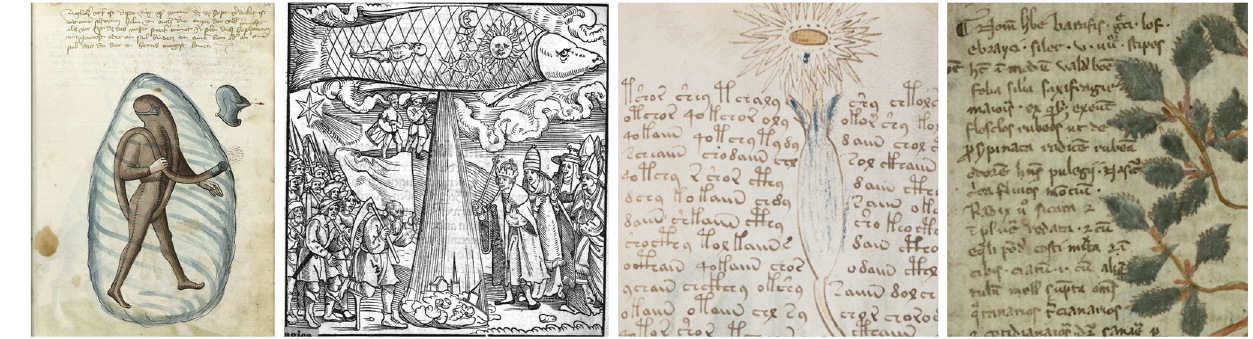
Fig 1. Four examples of historical codices. From left to right: MS Thott . 290 . 2° (1459; Photo: Royal Danish Library); Practica uber die grossen und manigfeltigen Coniunction der Planeten (1523; Photo: SLUB Dresden); Voynich Manuscript (Photo: Beinecke Rare Book and Manuscript Library, Yale University); MS O . 2 . 48 (14 th century; Photo: Trinity College Library, Cambridge). Just the Voynich Manuscript is considered as mysterious. (Selected by authors of this article by their